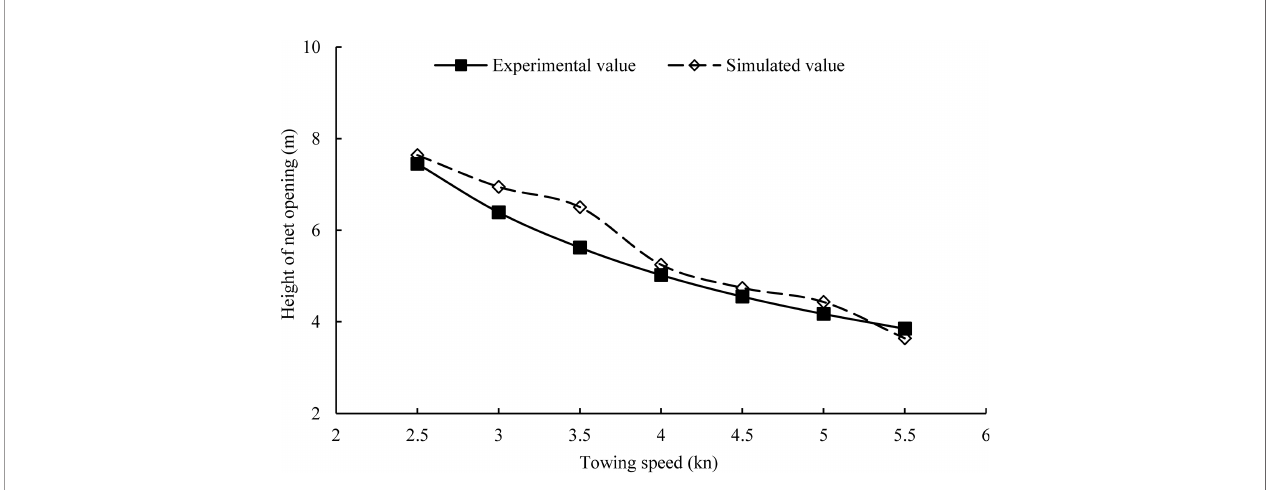
FIGURE 7 | Height of net opening.